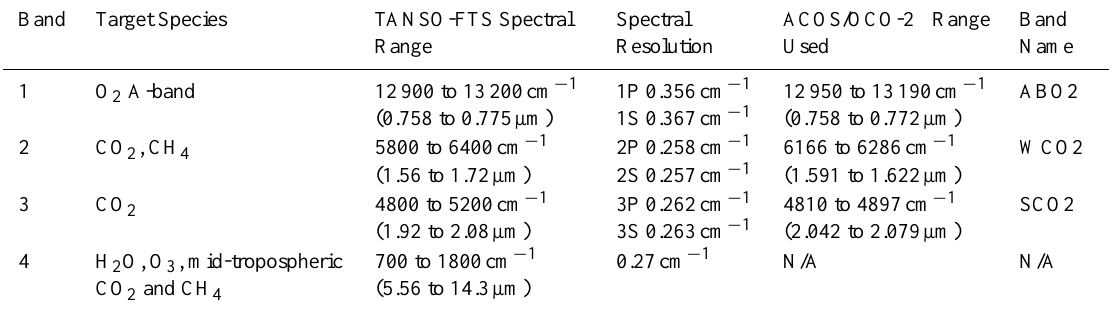
Table 1. GOSAT TANSO-FTS spectral bands and ACOS/OCO-2 spectral ranges. The spectral resolution (full width at half maximum of the instrument line shape function) for the two polarizations, P and S, are specified separately (Kuze et al. 2009a). Band Target